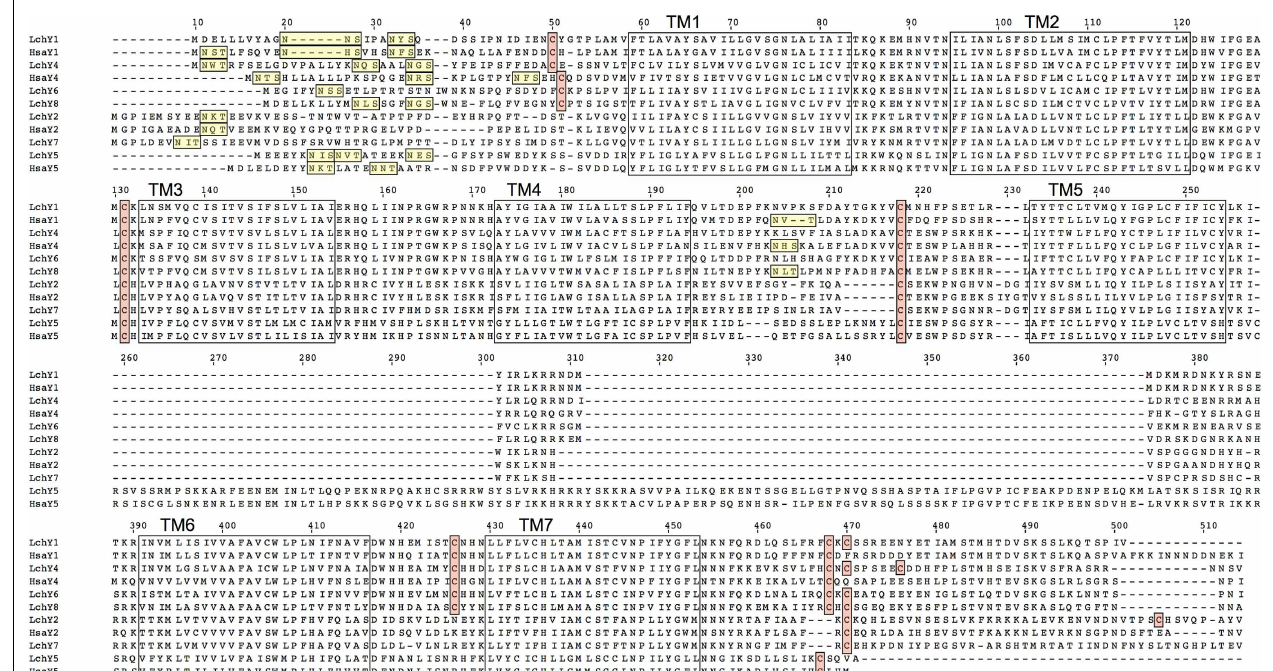
glycosylation in the aminoterminal region are underlined. Cysteines assumed to be involved in disulfide bonds are within boxes as are the cysteines in the carboxyterminal region that may serve as attachment sites for